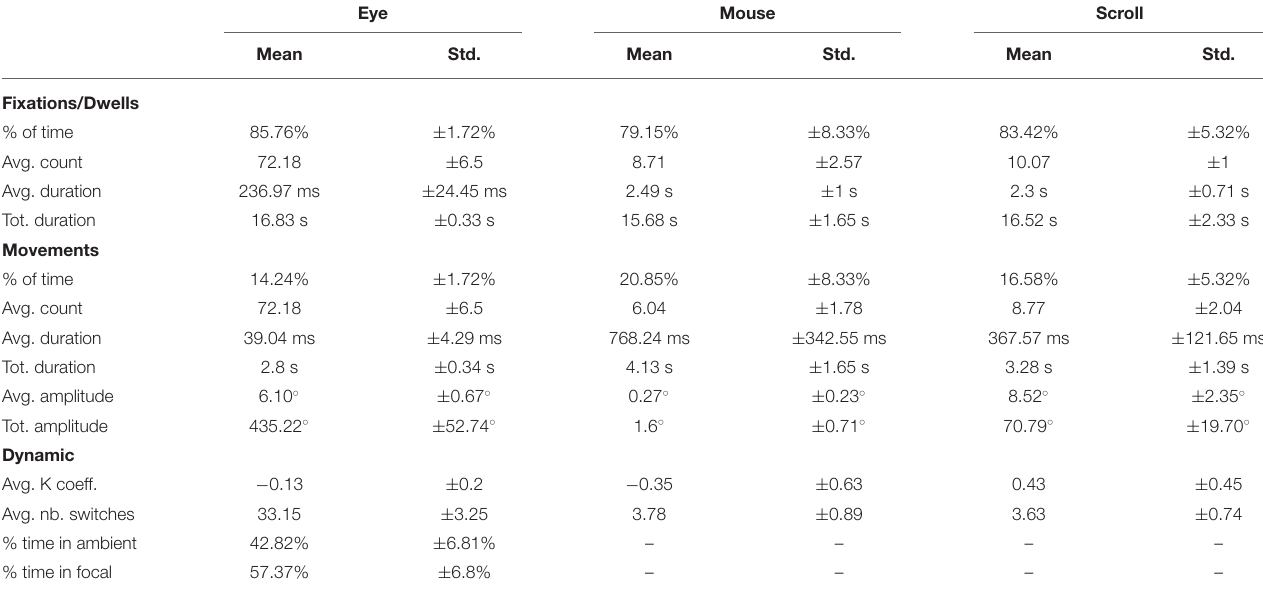
TABLE 1 | Global means and standard deviations of all studied variables (139 participants on 18 web pages for 20 s each). Eye Mouse Scroll Mean Std. Mean Std. Mean